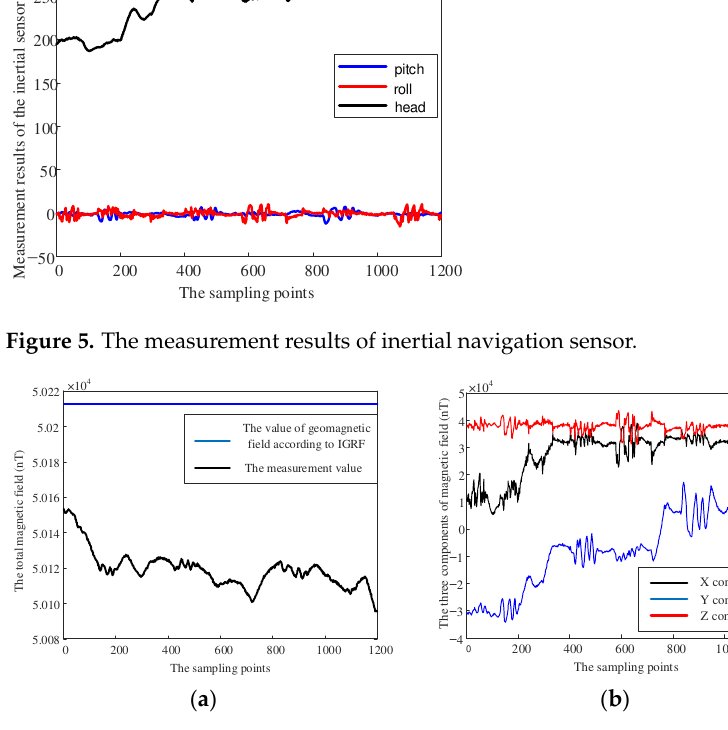
Figure 6. The measurement and decomposition results of the optical pump magnetometer: ( a ) the measured and true value of the total magnetic field; and ( b ) the decomposition results of the total magnetic field.